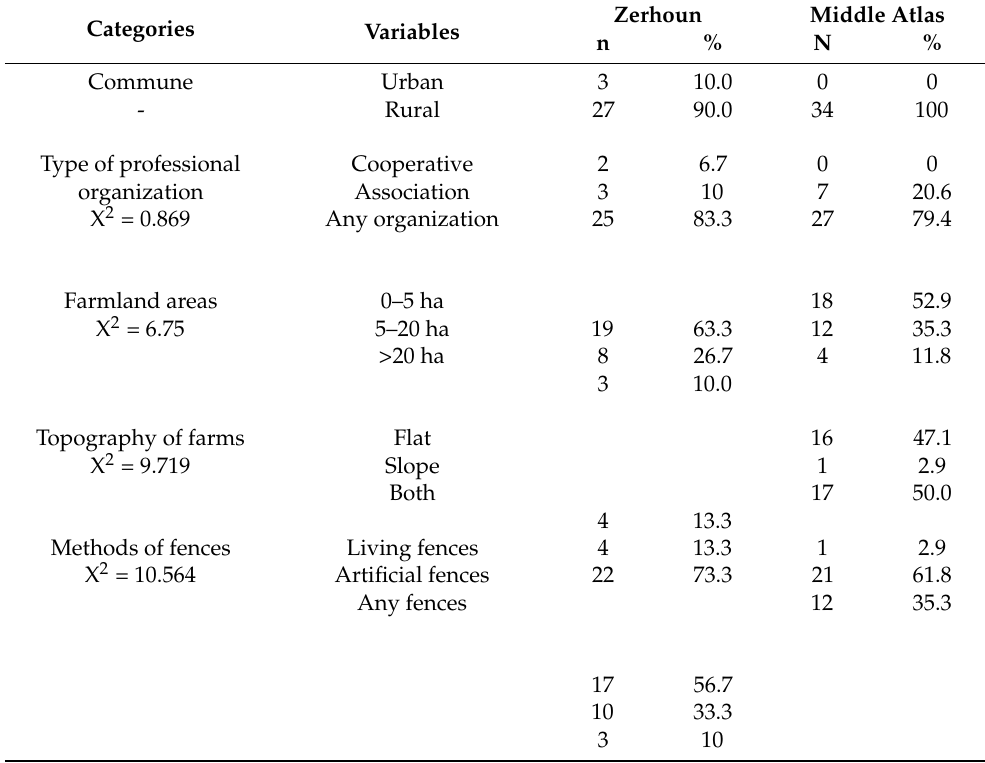
Table 1. Identification of